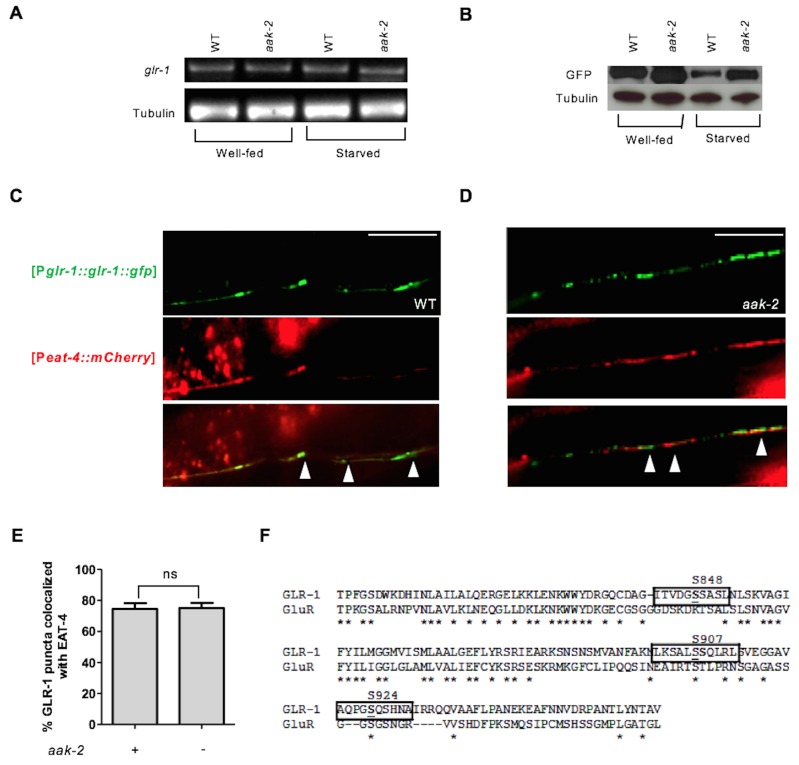
AMPK regulates GLR-1 abundance by affecting steady state protein levels.(A) Relative messenger RNA levels were analyzed with semi-quantitative RT-PCR in well-fed and starved animals. glr-1 mRNA levels were similar in well-fed and starved WT and aak-2 mutants. (B) Western blot analysis of GLR-1 levels in Well-fed and starved WT and aak-2 mutants expressing GLR-1::GFP using GFP antibody. GLR-1 protein levels decrease upon starvation in WT animals and this is less pronounced in aak-2 mutants. (C,D,E) Co-localization (arrows) of EAT-4 with GLR-1 is shown in the merged images. GLR-1 puncta were closely opposed to EAT-4 puncta in both WT (C) and aak-2 mutants (D) (n>7), Error bars represent ± SEM (Student's two-tailed t test). (F) A schematic showing the 3 AMPK phosphorylation sites in the cytoplasmic tail of the GLR-1 protein two of which are conserved between C. elegans and rat glutamate receptor GluR1.